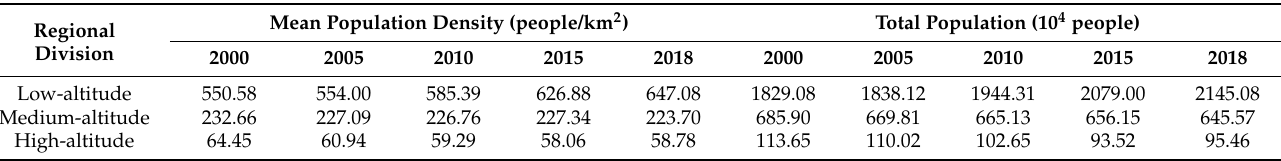
Table 6. Average population density and total population of each altitude